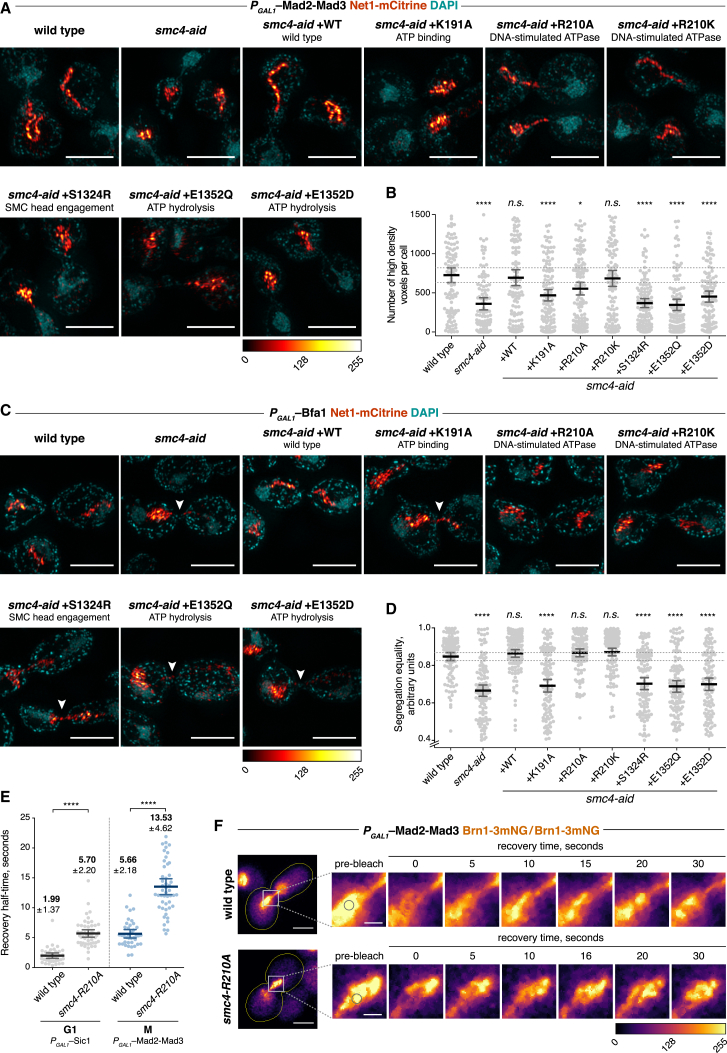
SMC ATPase Controls Chromosome Condensation, Segregation, and Condensin Turnover(A) Metaphase rDNA morphology of Smc4 ATPase mutants visualized by structured illumination microscopy of the rDNA binding protein Net1. Cells were synchronized in G1 with α factor and released into a metaphase arrest due to overexpression of a Mad2-Mad3 fusion protein. Scale bars represent 4 μm.(B) Quantification of rDNA condensation, measured by the number of high-density volumetric pixels in the high-frequency data of structured illumination images. Error bars represent mean ± 95% confidence interval (n ≥ 90); asterisks denote p values with respect to the first column (NS, not significant; ∗p < 0.05, ∗∗p < 0.01, ∗∗∗p < 0.001, ∗∗∗∗p < 0.0001; ordinary one-way ANOVA, Dunnett’s multiple comparison test).(C) rDNA segregation in Smc4 ATPase mutants visualized by structured illumination microscopy of the rDNA binding protein Net1. Cells were synchronized in G1 and released into a late anaphase arrest due to overexpression of Bfa1. Arrowheads indicate chromatin bridges. Scale bars represent 4 μm.(D) Quantification of rDNA segregation as the ratio of Net1 fluorescence intensity in the two cell halves. A ratio of 1 indicates equal segregation. Error bars represent mean ± 95% confidence interval (n ≥ 106); asterisks denote p values as in (B).(E) Fluorescence recovery half-times, following photobleaching, of the Brn1-3mNeonGreen signal in homozygous diploid wild-type and smc4-R210A cells, arrested in G1 by overexpression of Sic1 or metaphase by overexpression of Mad2-Mad3. Error bars represent mean ± SD (n ≥ 37) (ordinary one-way ANOVA, Sidak’s multiple comparison test).(F) Examples of fluorescence recovery of the Brn1-3mNeonGreen signal in wild-type and smc4-R210A cells (outlined) in metaphase, with the area around the bleach spot (indicated by circles) magnified for clarity. Scale bars for whole-cell images represent 4 μm; those for the inset represent 1 μm.See also Figure S4 for illustration of the high-density voxel chromosome condensation assay and confirmation of the cell-cycle arrests.